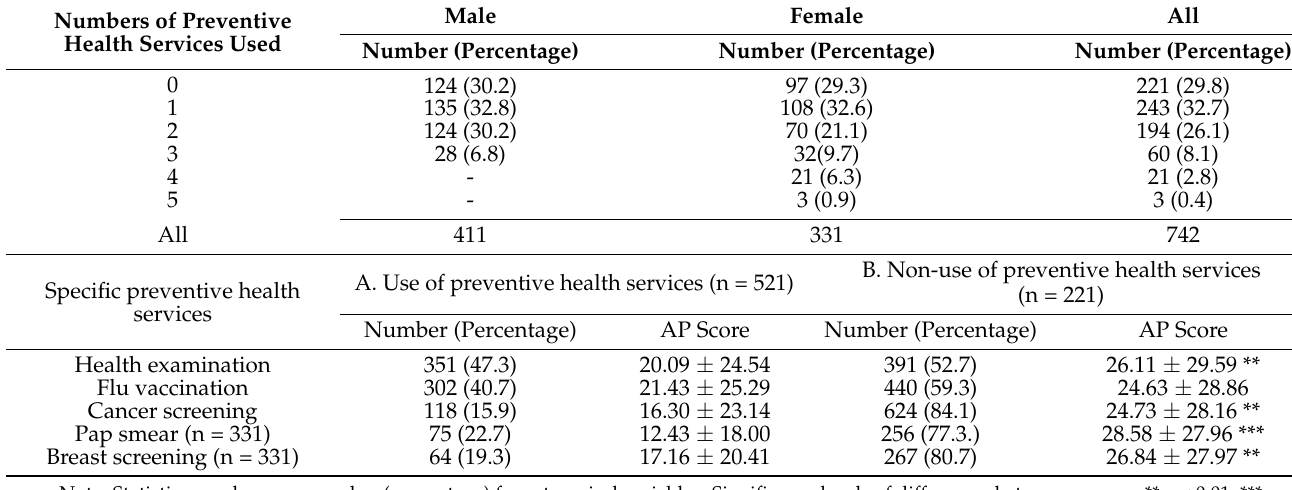
Table 2. Distribution of the use of preventive health services and AP scores for people with disabilities.